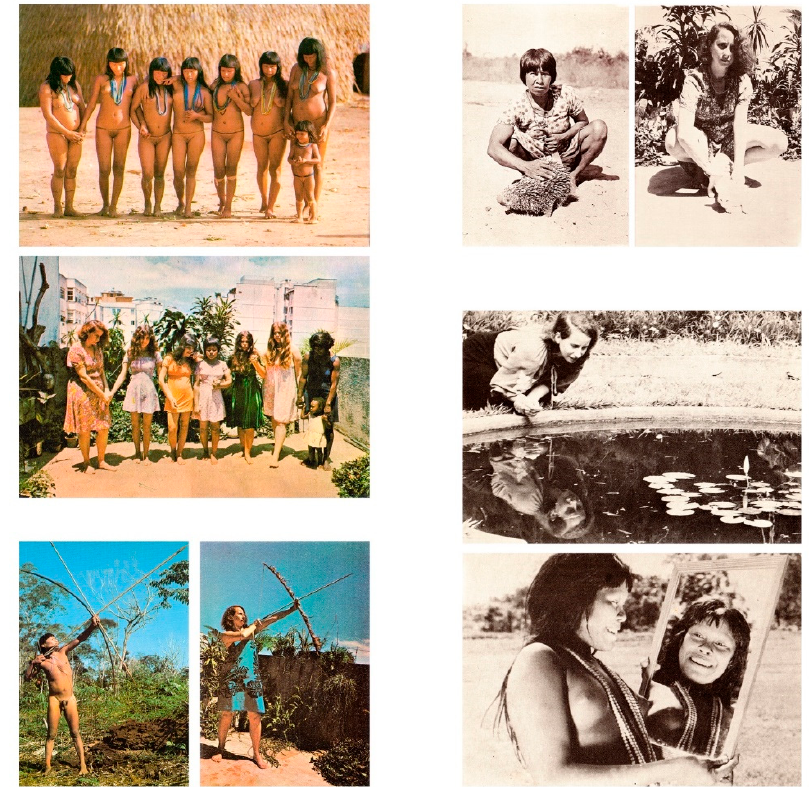
Figure 2. Bella Geiger, Brasil nativo, Brasil alienígena ( Native Brazil, Alien Brazil ), 1976–1977. Postcards. 17 1/8 × 46 in. (43.5 × 116.8 cm), framed. Limited edition. Courtesy of the artist and Henrique Faria, New York. 4.